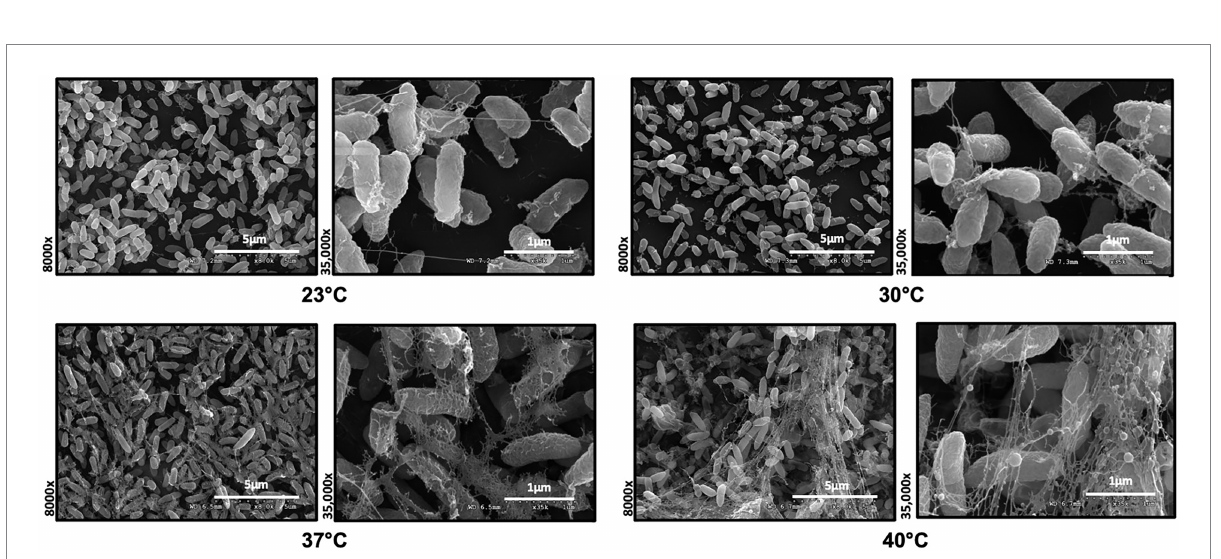
FIGURE 3 Microscopy reveals temperature-induced structural changes in P. aeruginosa biofilms. Comparison of the Scanning Electron Microscopy images of P. aeruginosa wild type biofilms grown for 48 h at 23 ° C, 30 ° C, 37 ° C and 40 ° C. Images show 8,000 Å ~ and 35,000 Å ~ magnification and are representative of three independent experiments.